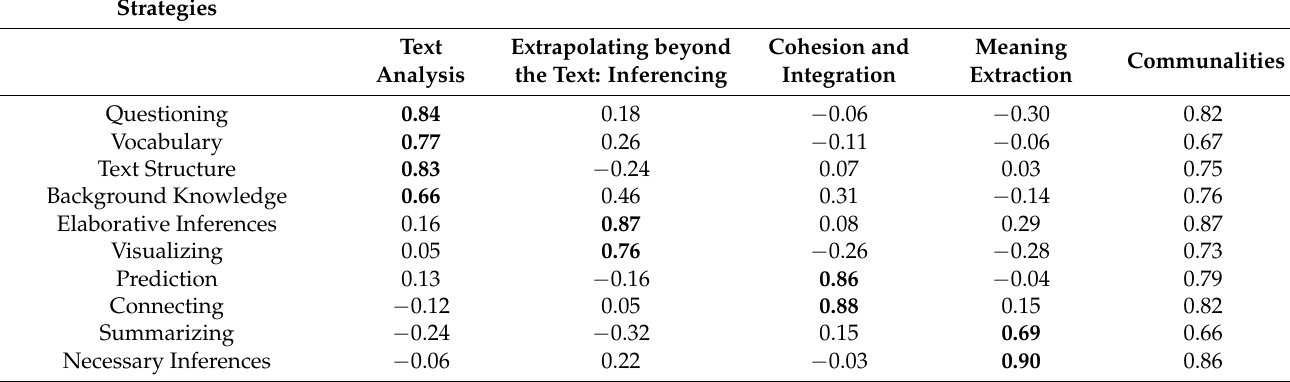
Table 5. Rotated Factor Loadings and Communalities for Each Strategy Used in English Think-Alouds.